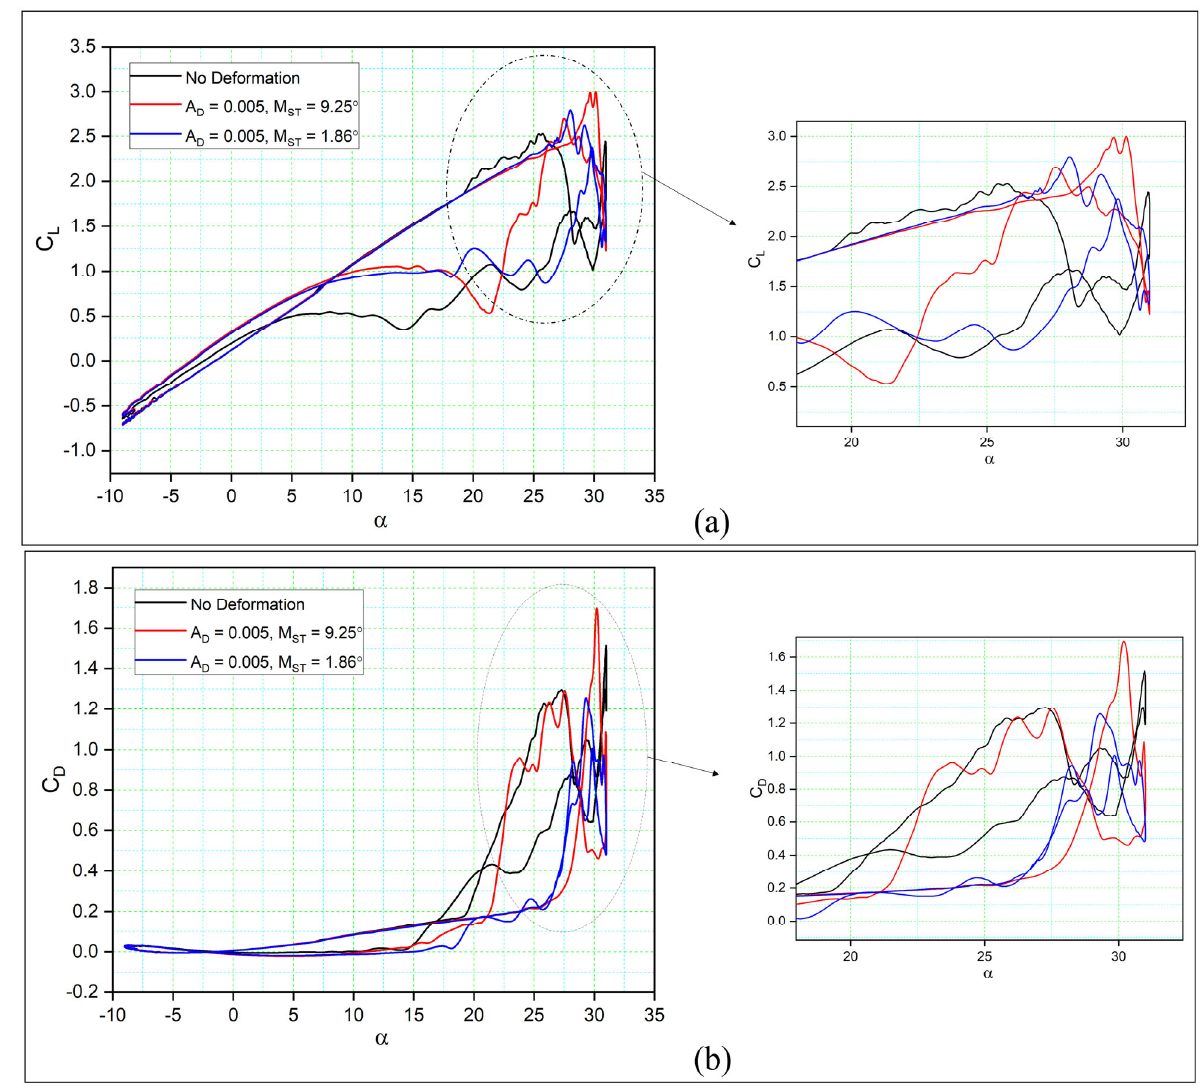
Figure 10. Hysteresis cycles for ( a ) the lift coefficients of DMLE airfoils and ( b ) the drag coefficients of DMLE airfoils, presented in comparison to the reference (unmorphed) airfoil.